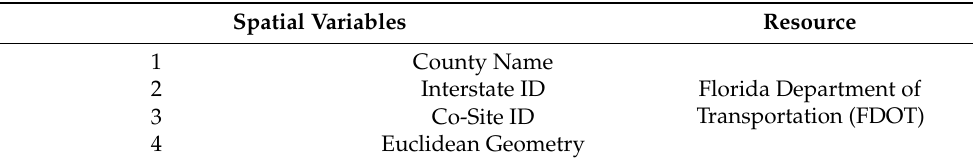
Table 5. Candidate spatial variables.